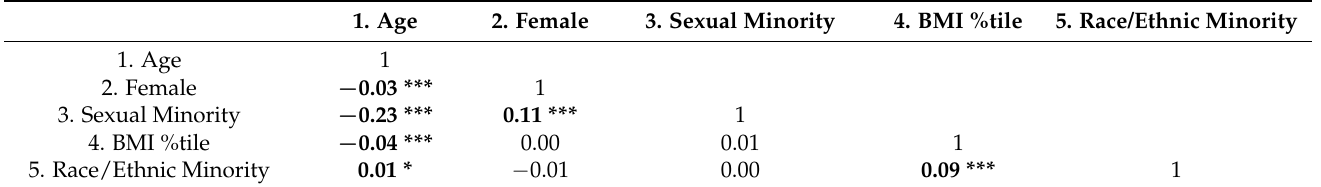
Figure 3. Weighted structural equation model showing the associations of physical activity, unsafe schools, and non-prescription steroid use, controlling for age, sex, BMI %tile, race/ethnicity, and sexual minority status. Note: Circles are latent variables and rectangles are observed variables; covariances between observed demographic variables and the latent factors are not displayed because of practical reasons but are reported within the text (Section 3.3) and within Table 3; bold denotes statistical significance, and *** p < 0.001. Table 3. Standardized covariances among demographic variables from the weighted structural equation